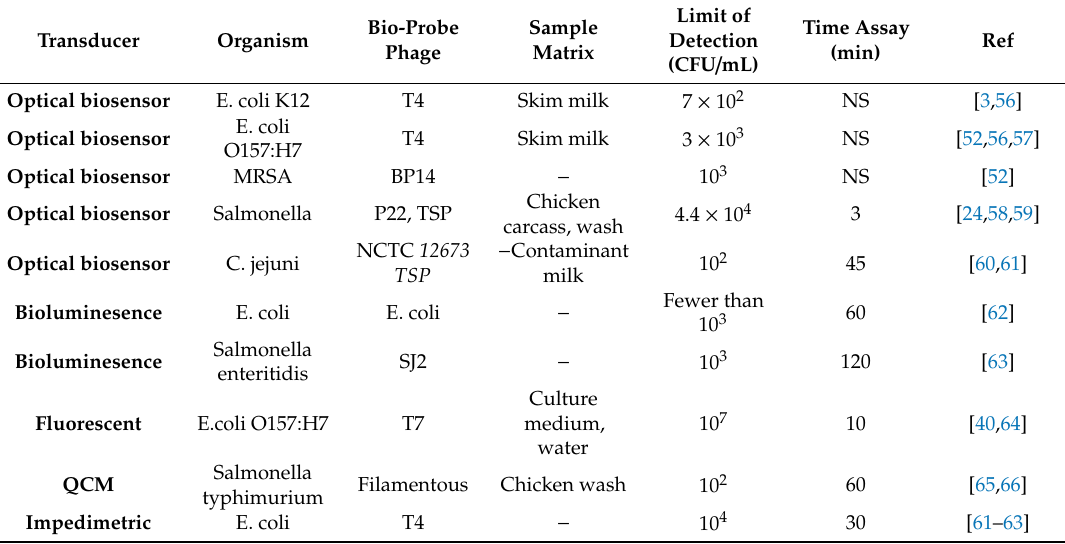
Table 2. Table based on phage-based biosensors in diagnosis of pathogens according to the type of phage, type of sample, duration of diagnosis and limit of detection achieved. Keys, NS, not